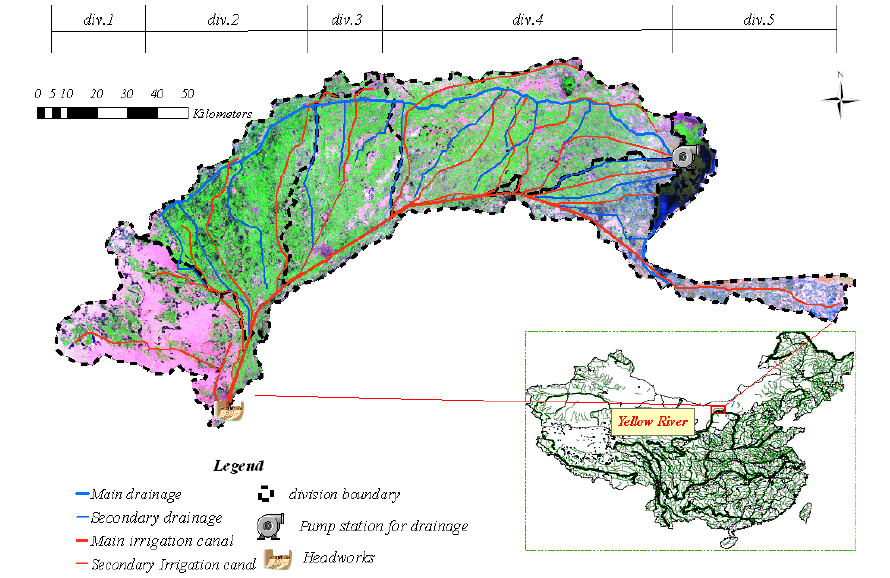
Figure 1. Schematic map of Hetao irrigation District (HID), Inner Mongolia, North China (Based on mosaiced LANDSAT images acquired on August 9,